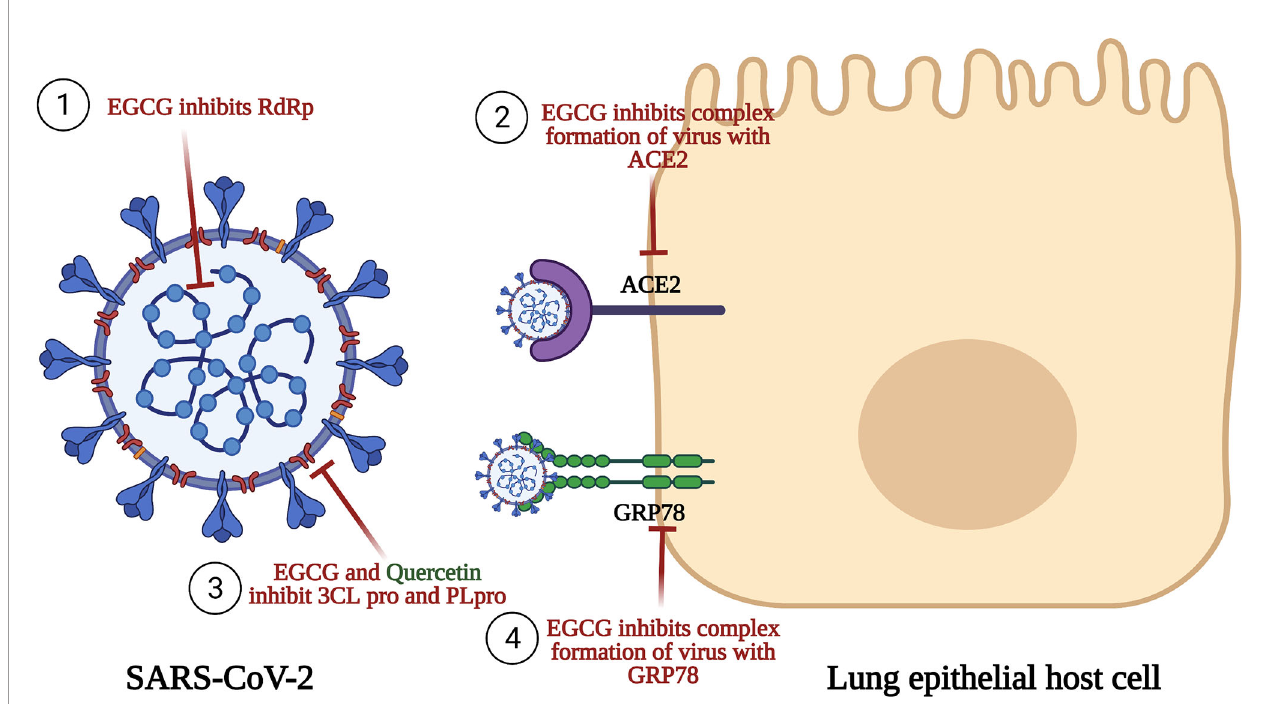
FIGURE 4 | Anti-SARS-CoV-2 activities of EGCG and quercetin. This fi gure illustrates the anti-SARS-CoV-2 for both EGCG and quercetin. EGCG inhibits RNA- dependent RNA polymerase (RdRp), an enzyme having an important role n replication and transcription of the virus. EGCG also inhibits the binding of the S1 region of the viral spike protein to the ACE2 receptor on the lung host cells. EGCG and quercetin prevent the processing of polyproteins pp1a and pp1ab by Papain-like protease (PL pro ) and Chemotrypsin-like protease (3C like protease or 3CL pro or M pro ). Finally, EGCG inhibits complex formation of the virus with GRP78 receptor and thus inhibits viral